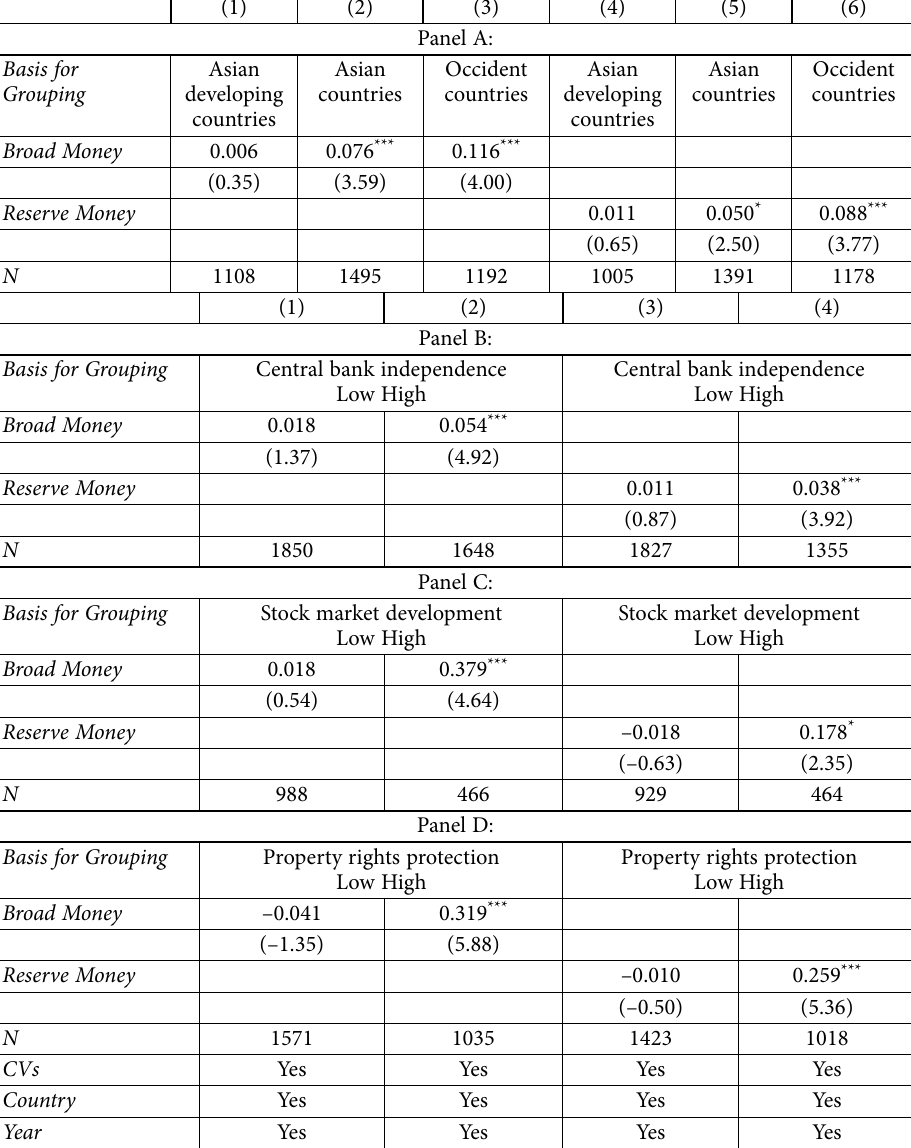
Table 8. Heterogeneity analysis of monetary policy transmission